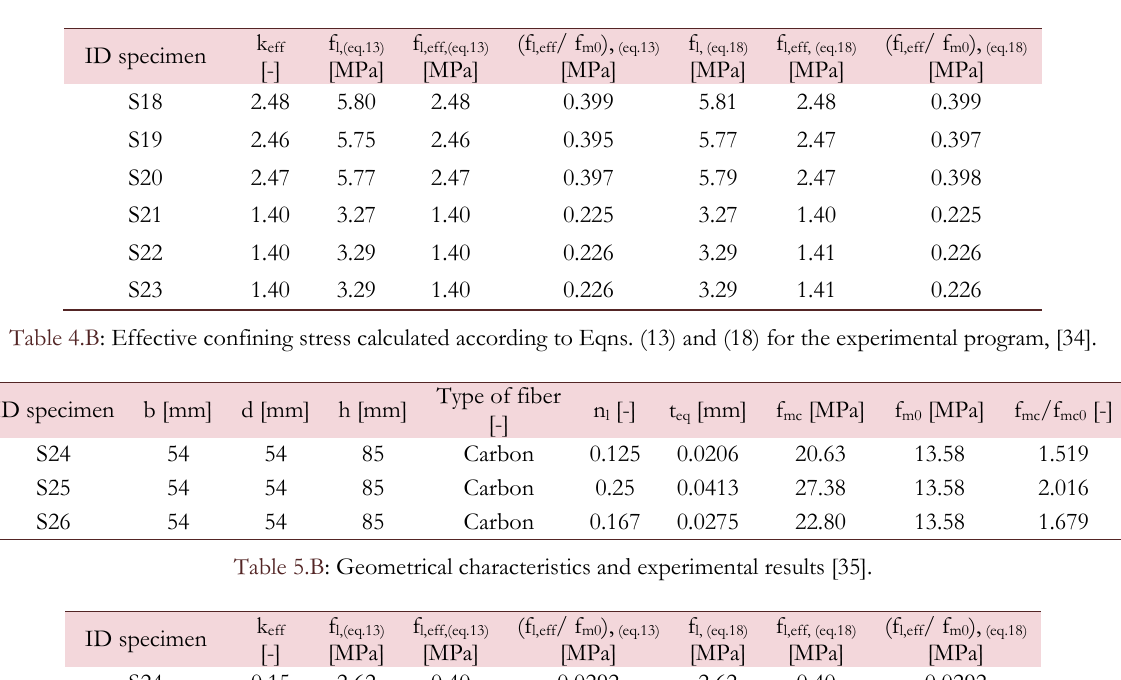
Table 3.B: Geometrical characteristics and experimental results [34].